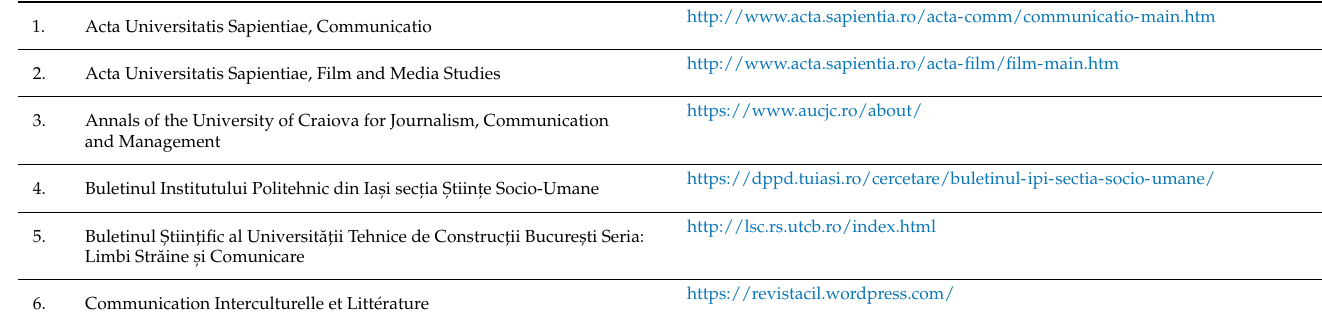
Table A1. List of Romanian journals in communication science and their